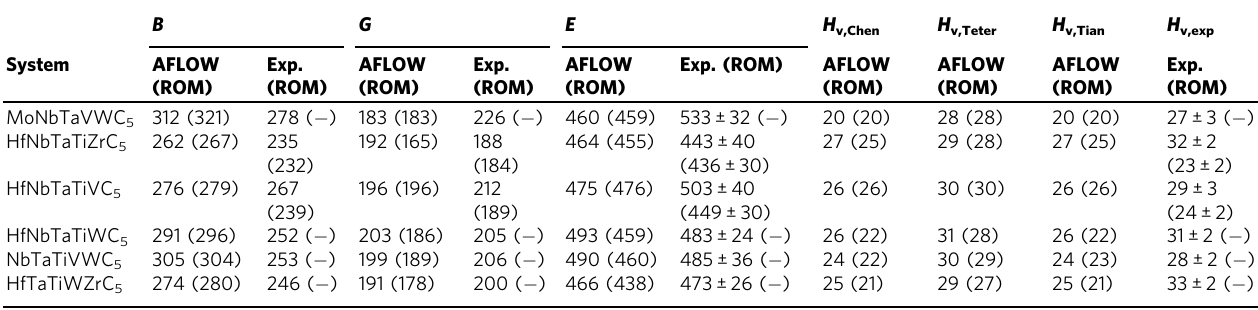
for Mo- and W-containing compositions are not available, as indicated by ( – ). Units: B , G , E , and H V in (GPa)